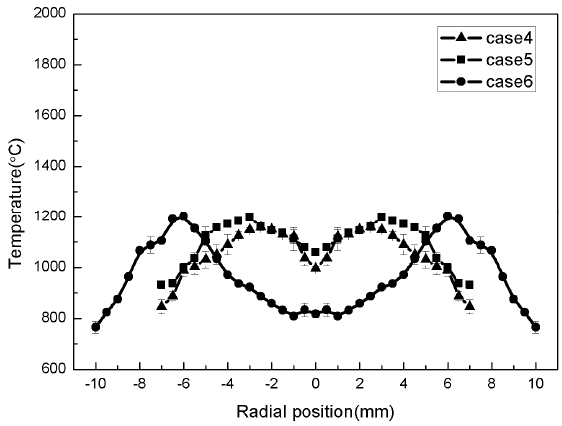
Figure 8. Variation of measured flame temperature with radial distance for three flames.